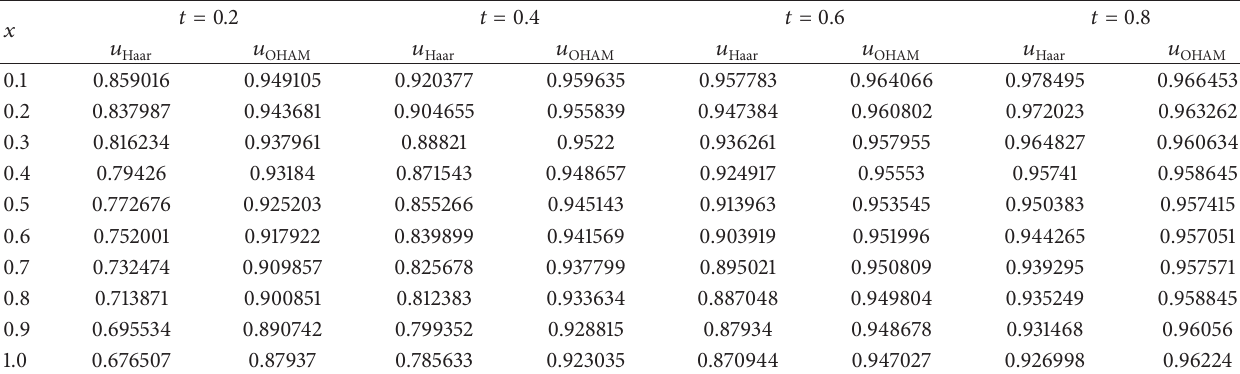
Table 8: The approximate solutions of generalized Fisher equation (49) using Haar wavelet method and five terms for fourth-order OHAM with convergence control parameters 𝐶 1 = −0.33833012 , 𝐶 2 = −0.04303056 , 𝐶 3 = 0.1230816 , and 𝐶 4 = −0.0545852 at various points of 𝑥 and 𝑡 for 𝛼 = 0.25